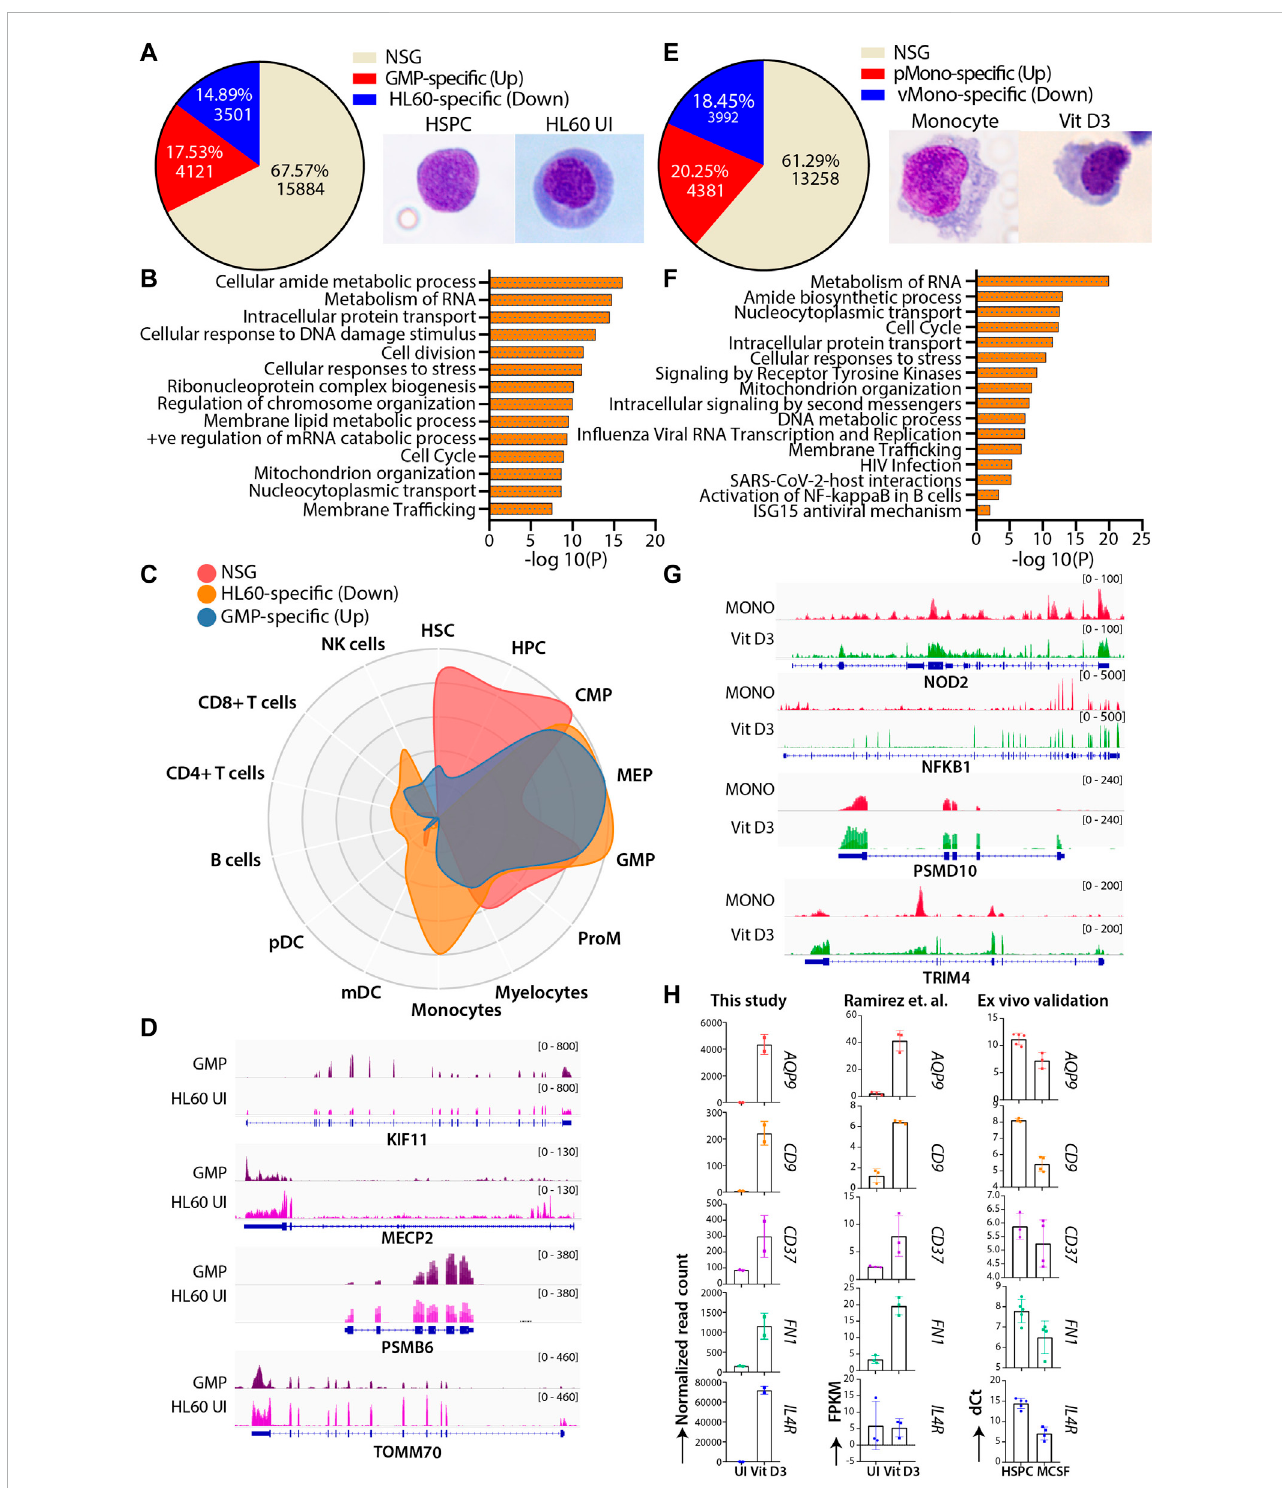
Comparative transcriptomic pro fi les of the HL60 (n = 2) vs GMP (n = 4) and Vit D3 induced HL60 (n = 2) vs primary monocytes (n = 4). (A) Venn diagram representingthedifferentialgeneexpressionpro fi leofHL60uninducedcellwithGMP.Thedifferentialgeneexpressionanalysisresultedinupregulatedgenes ( > 1-fold change, 17.53%, n = 4121, adjusted p -value ≤ 0.05), downregulated genes ( < 1-fold change, 14.89%, n = 3501, adjusted p -value ≤ 0.05) and genes that did not satisfy |log2FC| > 1 and FDR < 0.05 (NSG) (67.57%, n = 15884). (B) Bar plots representing the NSG-speci fi c biological pathways (signi fi cance -log10 as the p -value) such as cell cycle, translation, intracellular protein transport, metabolism of lipid, and metabolism of RNA conserved between the GMP andtheuninducedHL60cells. (C) CellRadarimagerepresentingtheoverallrelatednessbetweenGMPanduninducedHL60cells. (D) RepresentativeIGVplots showing the gene expression levels of the KIF11, MECP2, PSMB6, and TOMM70 in GMP and uninduced HL60. (E) Venn diagram representing the differential gene expression pro fi le of Vit D3 induced-monocytes with primary monocytes. Overall relatedness of the primary bone marrow monocytes with the Vit D3inducedmonocytes. The differentialgene expressionanalysis for theVitD3-inducedmonocytes showed upregulated genes ( > 1-fold change, 20.25%, n=